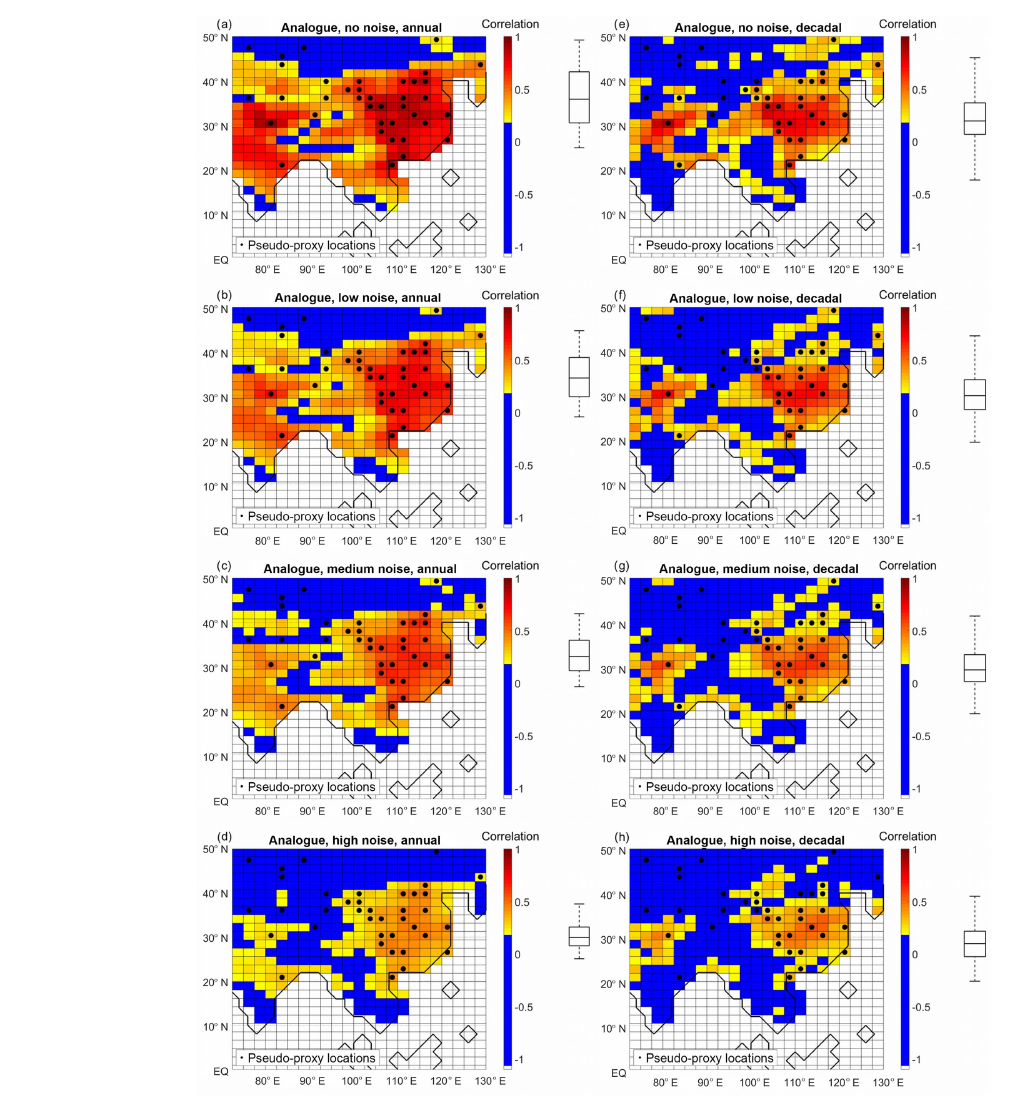
Figure 9. Analogue method performance in terms of correlation with target for different levels of noise at annual (a, b, c, d) or decadal (e, f, g, h) resolution. (a, b) No noise. (c, d) Low noise. (e, f) Medium-level noise. (g, h) High noise. The boxplots (indicating median, 25% and 75% percentiles and non-outlier limits) to the right of the colour bars show the distribution of the grid-point correlation coefficients. Black dots: pseudo-proxy